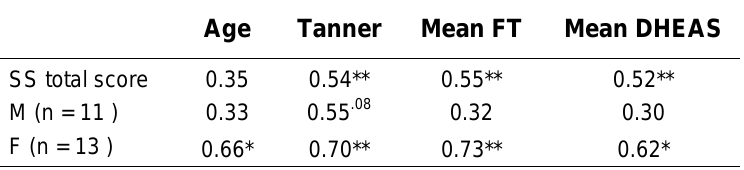
Spearman’s Rank Correlation of Age, Tanner, Mean Free Testosterone (FT), DHEAS, SS, and ODD Age Tanner Mean